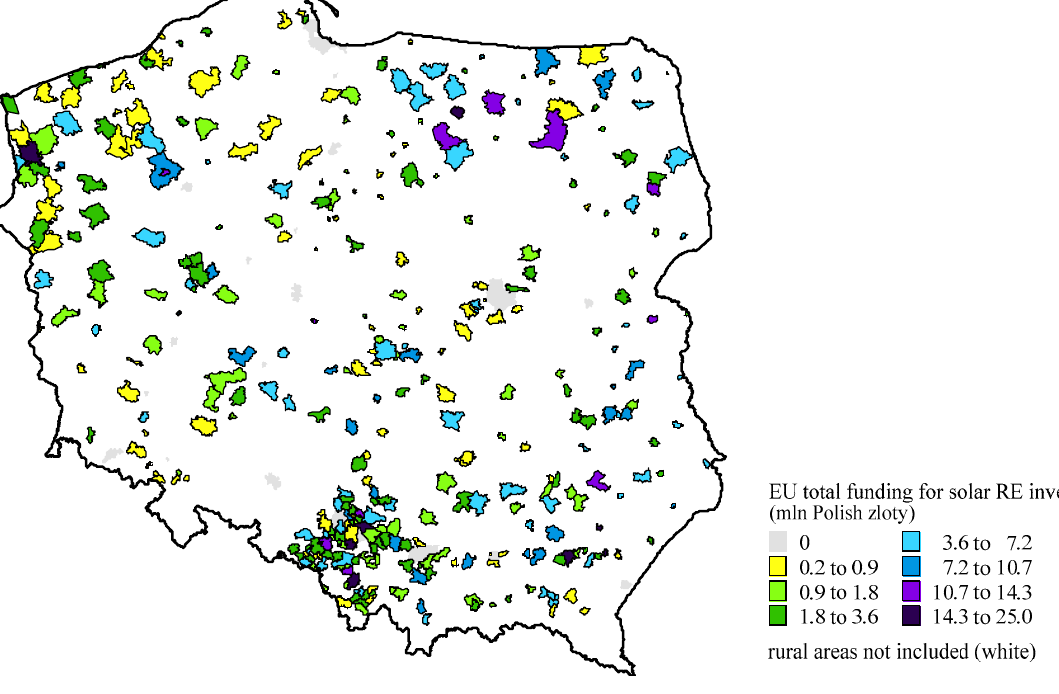
Figure 3. Total value of EU funds for solar RE investments in urban areas under operational pro-